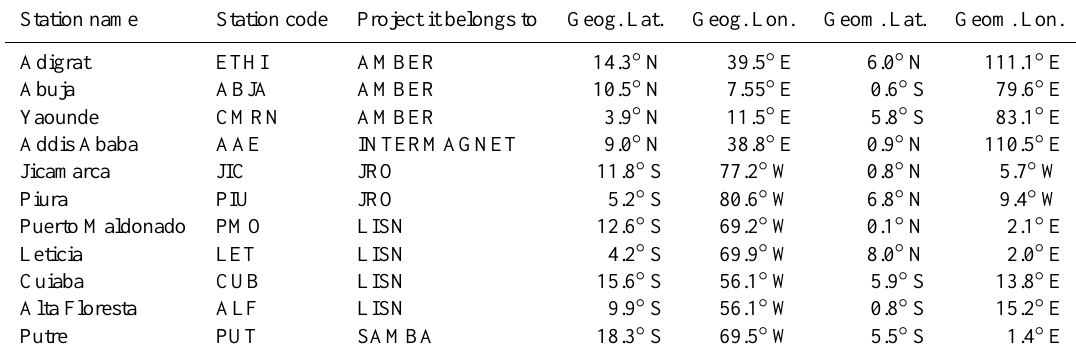
Table 1. List of magnetometer stations used.